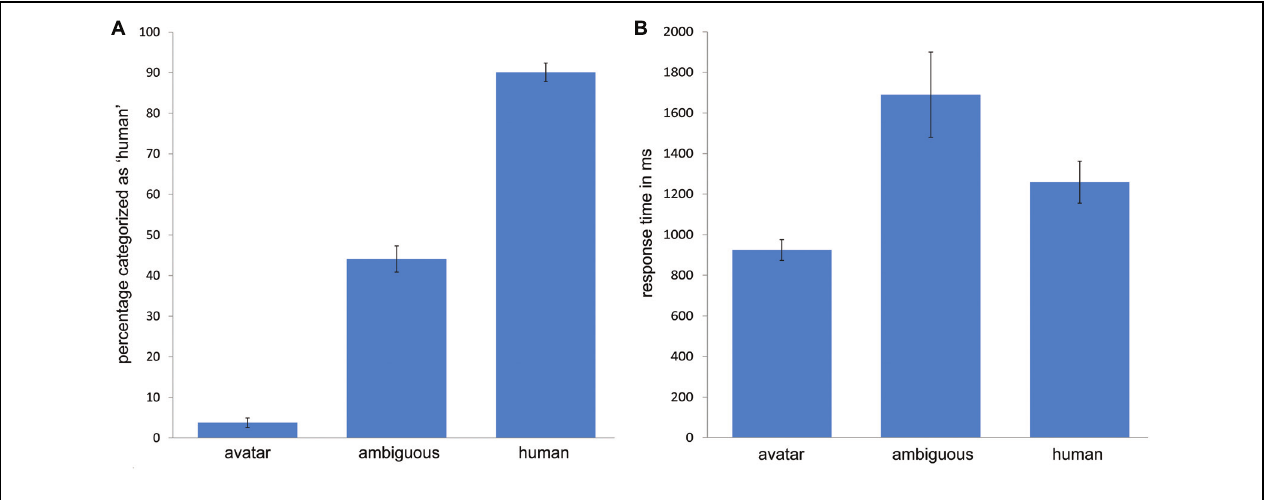
FIGURE 2 | Mean categorization responses and response times in the two-alternative forced choice categorization task. Mean categorization responses are depicted in terms of percentage of ‘human’ responses (A) for morphs representing unambiguous avatar and human faces and the most